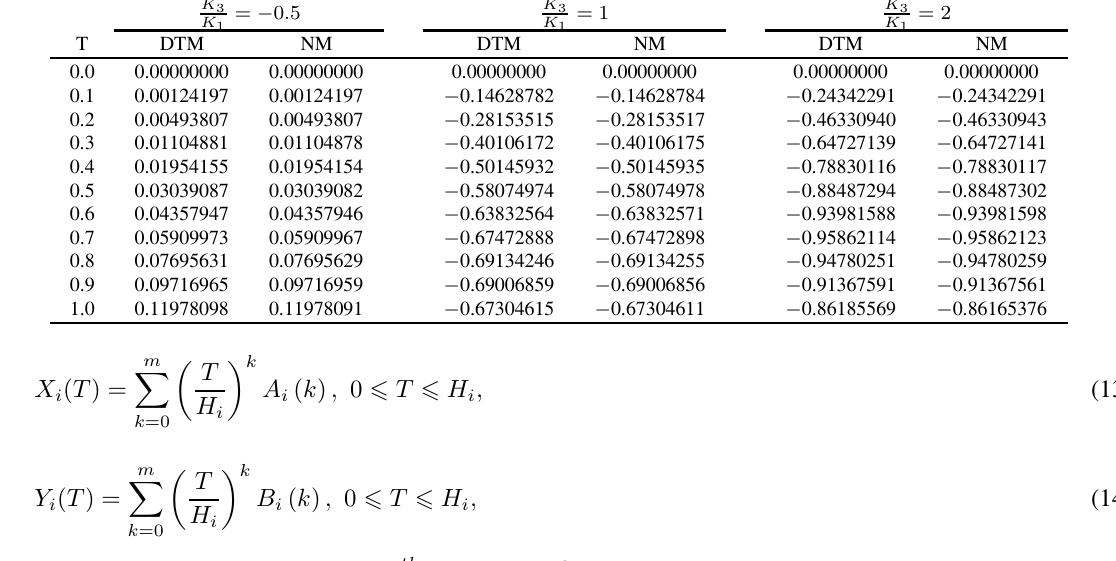
Table 5 when ζ = 0 . 1 , Ω = 0 . 5 and P = 1